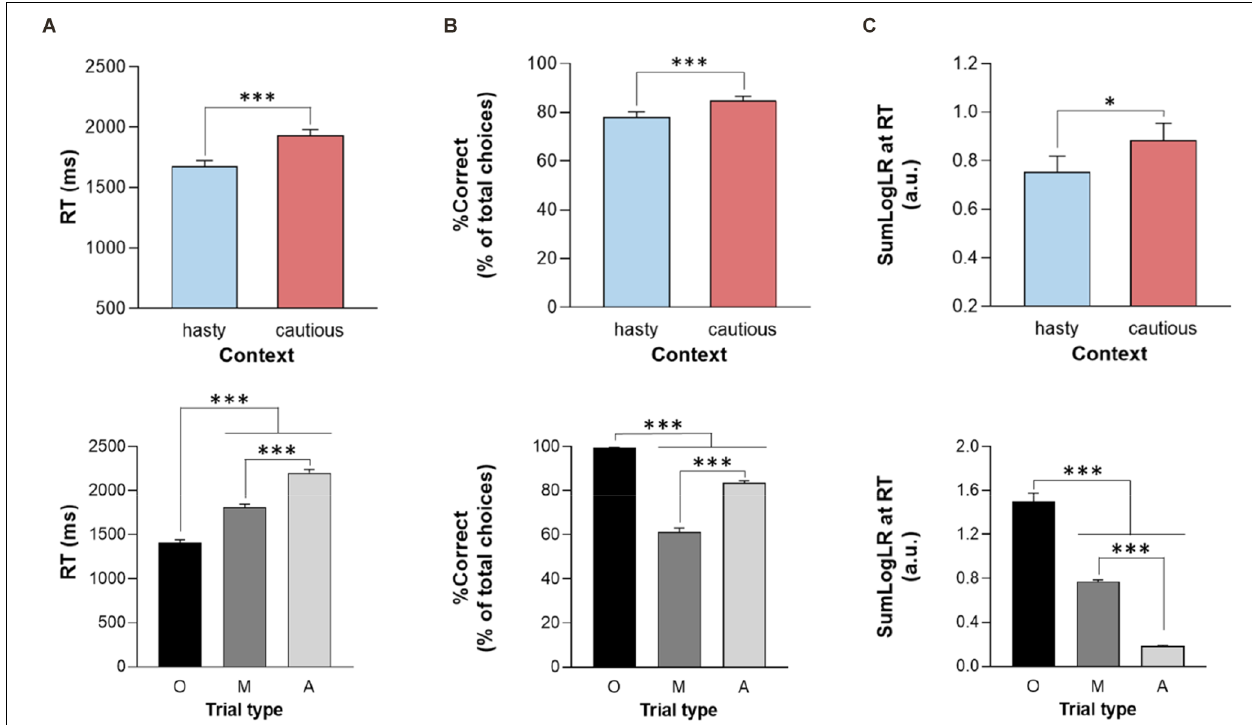
FIGURE 2 | Reaction time ( A ; RT), percentage of correct choices ( B ; %Correct), and sensory evidence at RT ( C ; SumLogLR at RT), depending on the context (upper panel; hasty or cautious), and the trial type [lower panel; Obvious (O), Misleading (M) or Ambiguous (A)]. Error bars represent SE. ∗ p < 0.05, ∗∗∗ p < 0.001: significantly